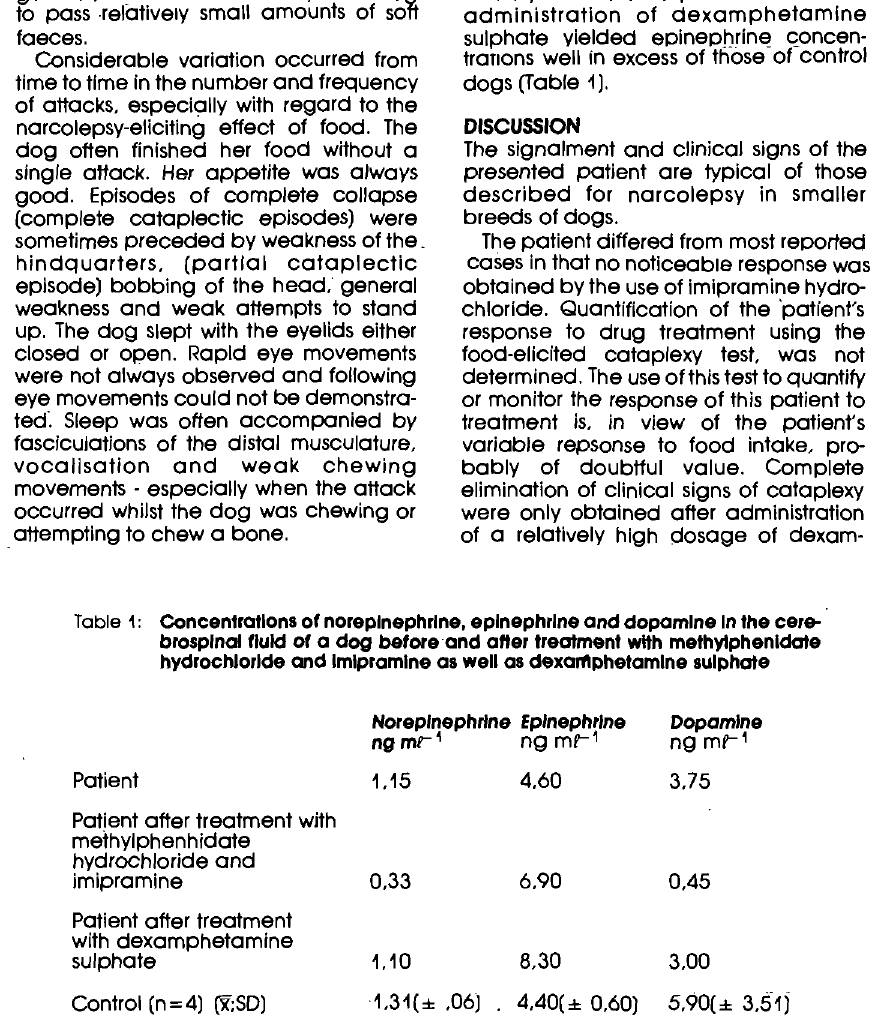
Table 1: Concentrations of norepinephrine. epinephrine and dopamine In the cere- ' brosplnal fluid of a dog before-and after treatment with methylphenidate hydrochloride and Imipramine as well as dexarftphetamlne